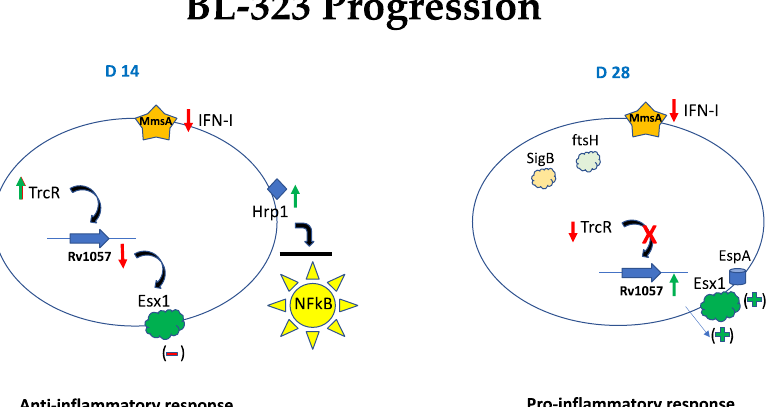
Figure 6. Schematical model describing key genes involved in progression of the infection in the murine model of the strain BL-323 at day 14 and 28 PI. Up and green arrows indicate over-expressed genes and down and red arrows indicate under-expressed genes.